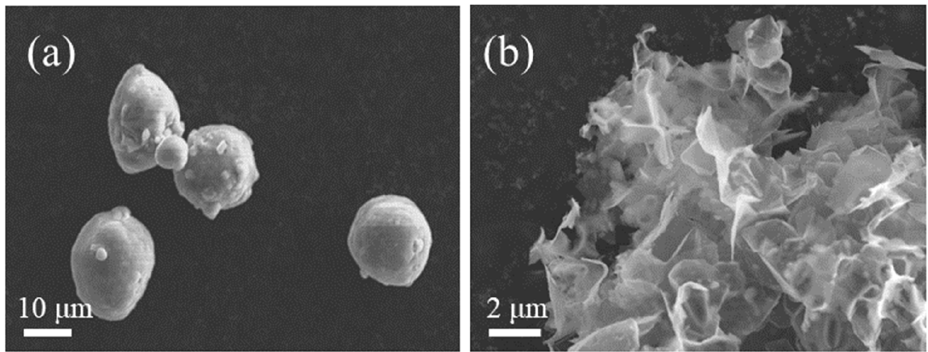
Figure 1. SEM morphologies of the raw materials ( a ) aluminum and ( b ) 3DGN.